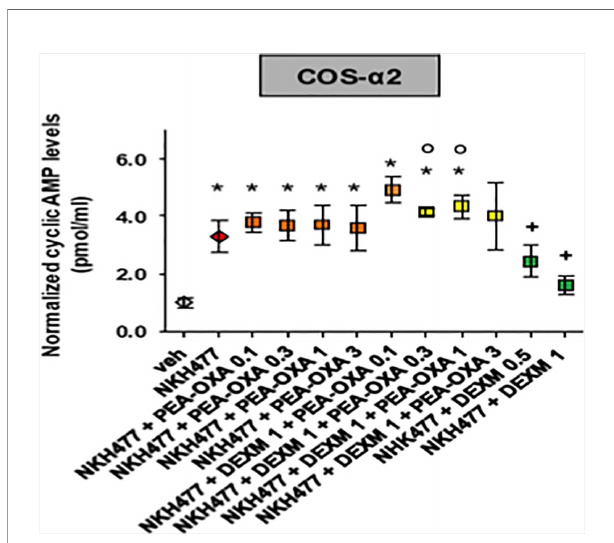
FIGURE 7 | Effect of PEA-OXA in COS cells stably expressing human adrenergic a 2 receptors. Scatter plots showing the effect of PEA-OXA in COS cells expressing a 2 receptors on intracellular AMPc levels. Data represent the mean ± S.E.M. of four/ fi ve separate determinations. Data sets were compared using one-way ANOVA followed by Bonferonni's test. *** p value ≤ 0.001 vs the indicated experimental groups; *p value ≤ 0.05 vs